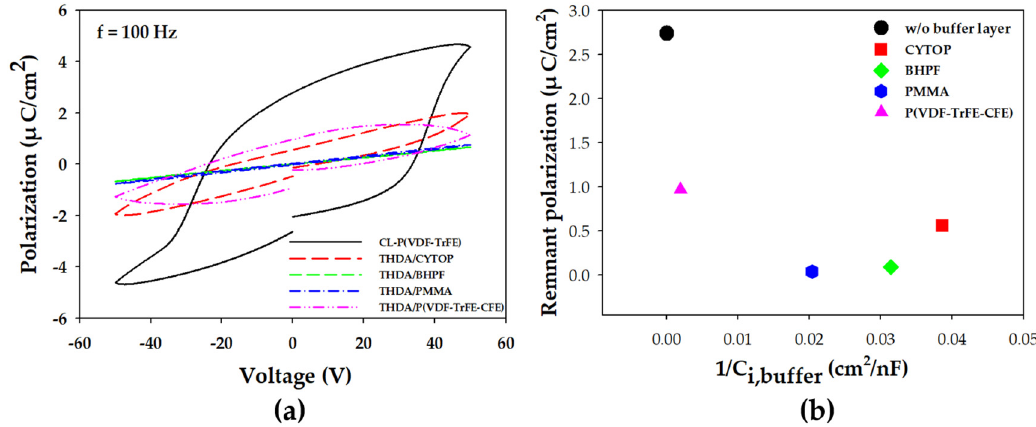
Figure 2. ( a ) Polarization–voltage characteristics of capacitors with B/F bilayers. ( b ) The remnant polarization ( P r ) monitored with C i,buffer . The thickness of the CL-P(VDF-TrFE) was used as the based reference (d = 0) to calculate the respective capacitance ( C i,buffer ) of the buffer layers.